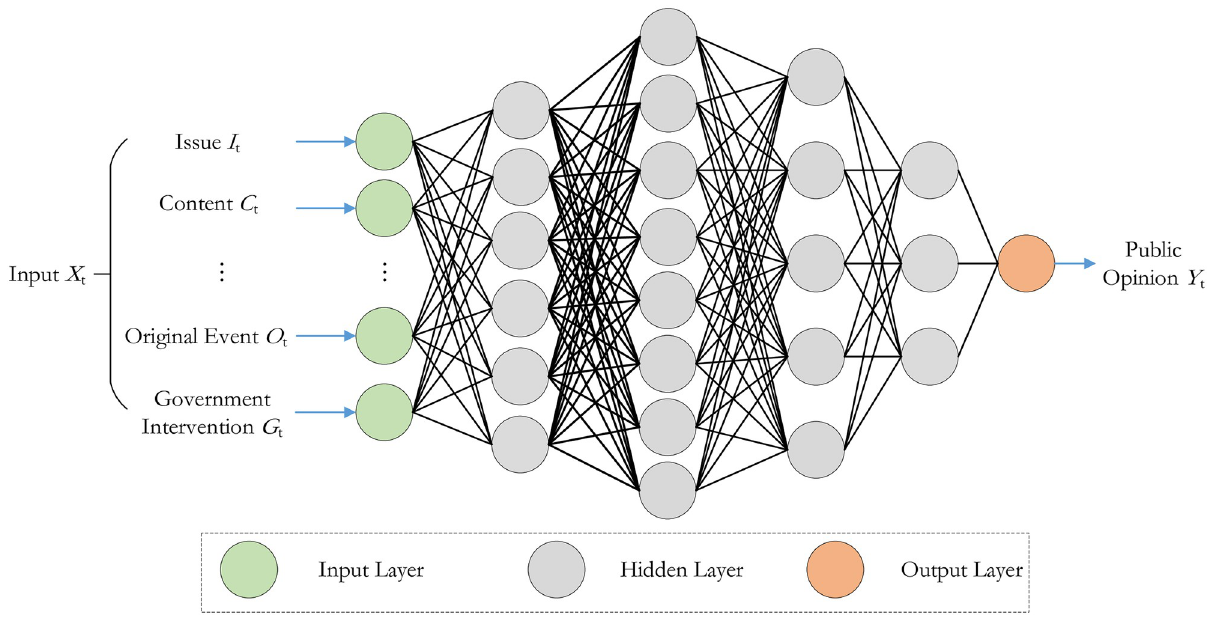
Fig 4. Construction of fully connected neural network